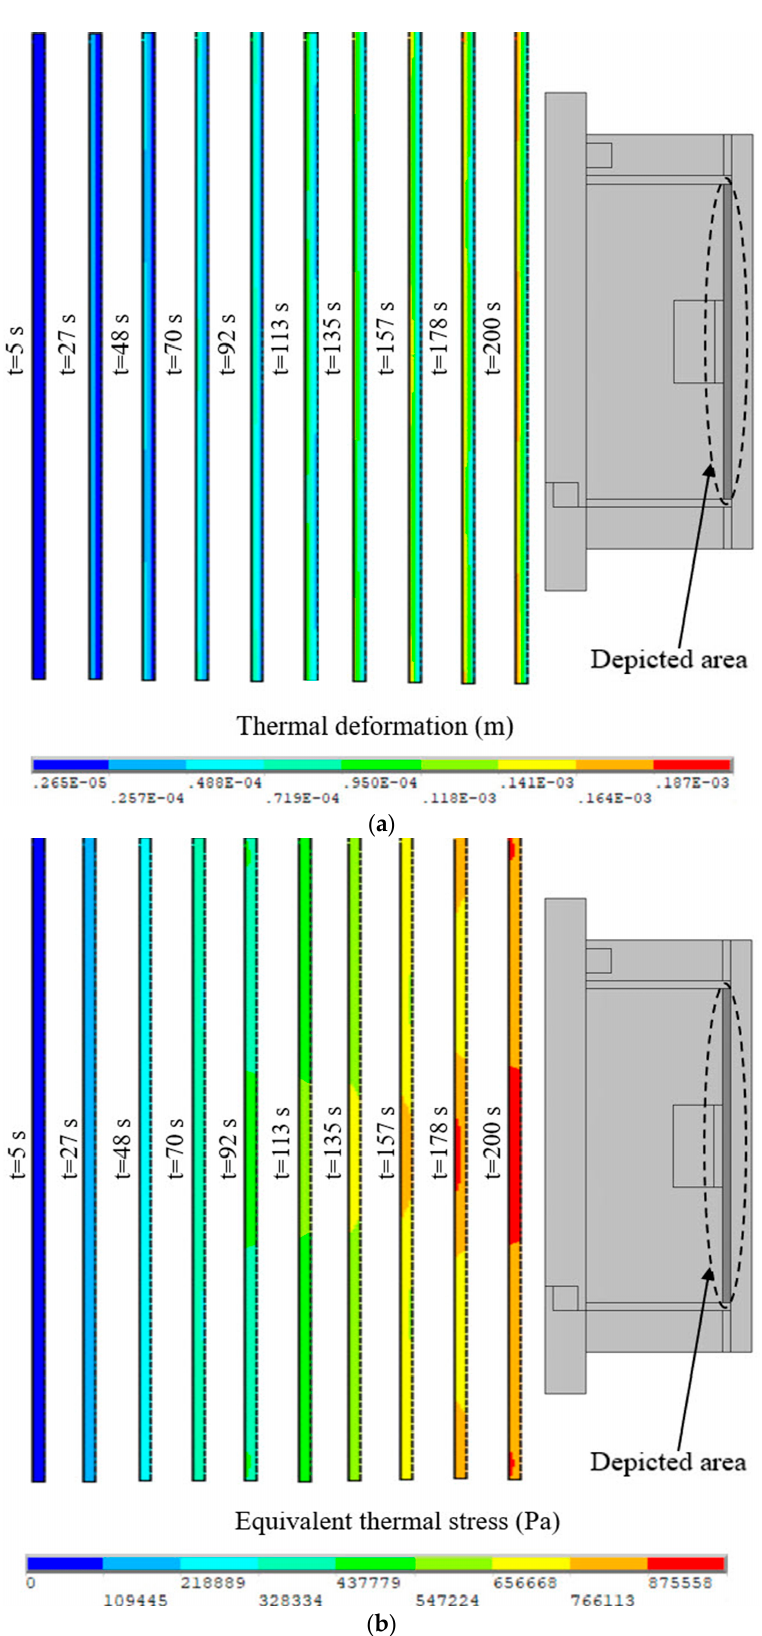
Figure 9. Results of the cylinder ‐ type MRC: ( a ) Thermal deformation of MRFs; ( b ) Equivalent thermal stress of MRFs.